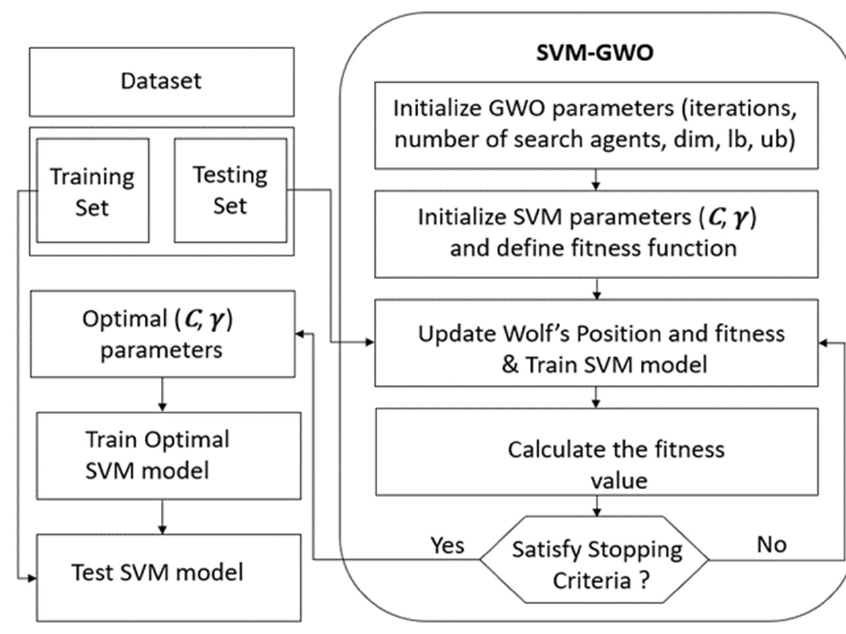
Figure 5. The flowchart of our proposed GWO-SVM algorithm.